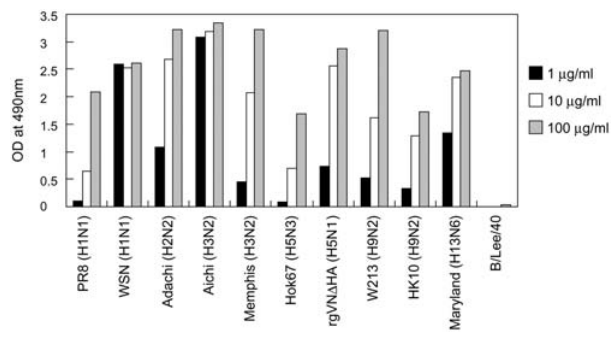
Figure 1. Reactivity of MAb S139/1 to various influenza virus strains. Binding activity of MAb S139/1 at the concentrations of 100 m g/ml (grey), 10 m g/ml (white), and 1 m g/ml (black) to the indicated virus strains was measured by ELISA as described in Materials and Methods.